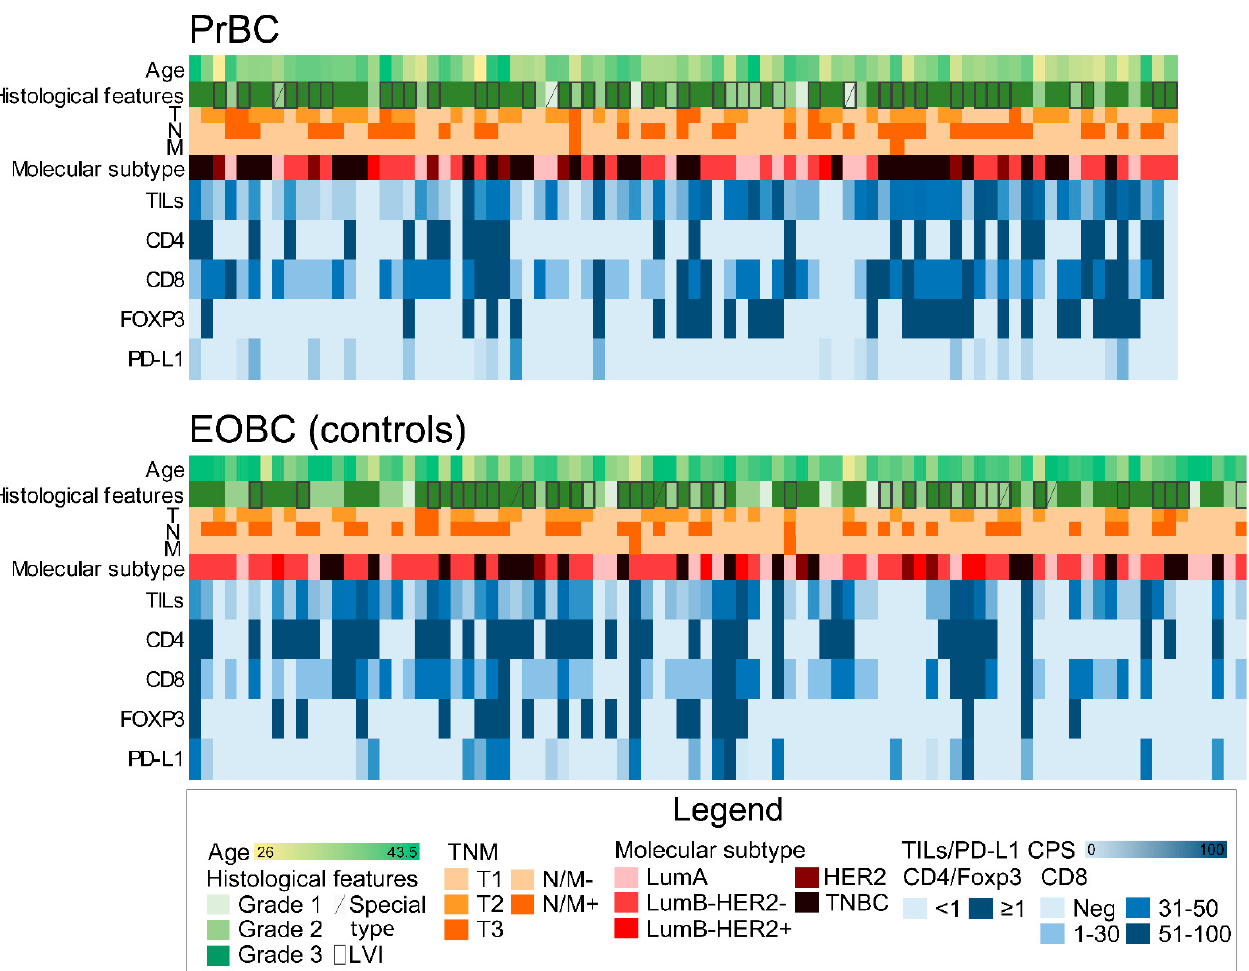
PrBC ( p < 0.01), with EOBC showing an intermediate frequency compared to MSK in all subgroups of breast cancers ( p < 0.01), as shown in Figure 2B and Supplementary Table S2. These data confirm the high frequency of TNBC in PrBC, still after correcting the comparison for the age of the patients.